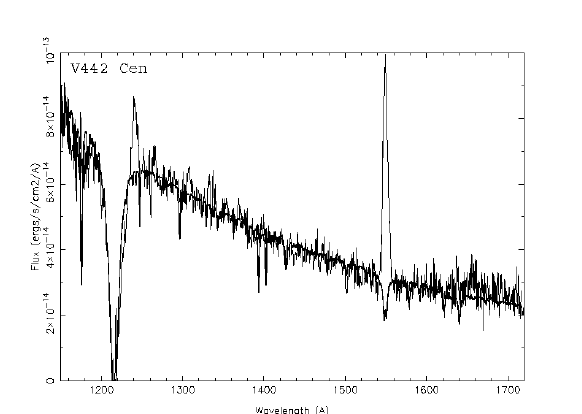
Figure 1: The best-fitting single temperature WD fit to the HST/STIS spectrum of V442 Cen. The model consists of a 47,000K WD with Log(g)=8.3 and scaled to a distance of